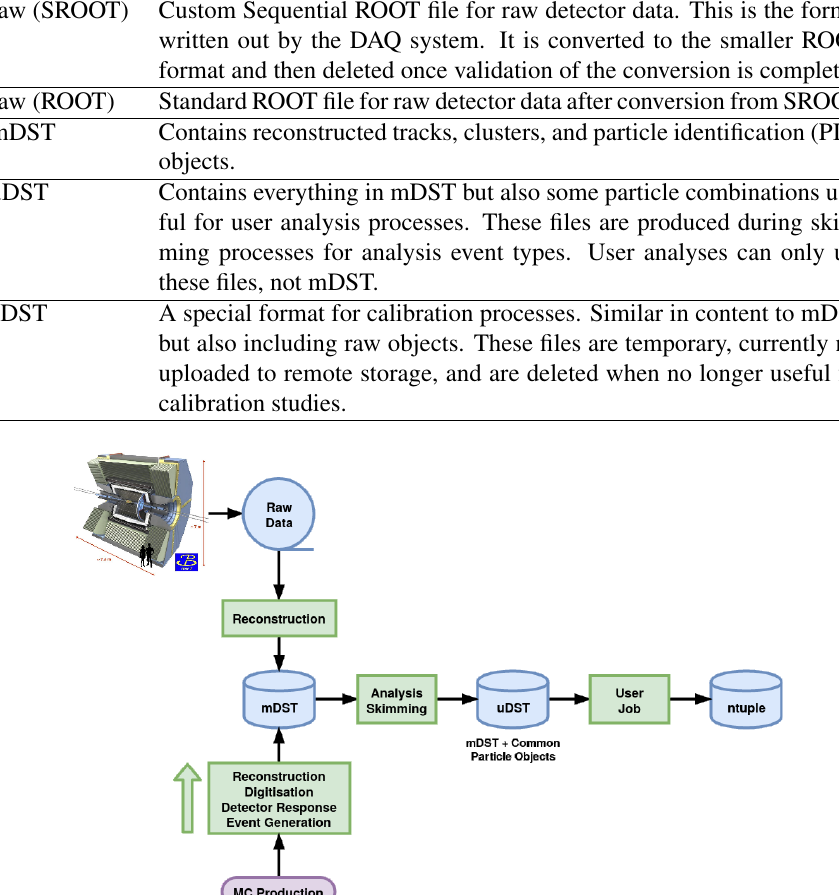
Figure 3. Simplified data model of the Belle II